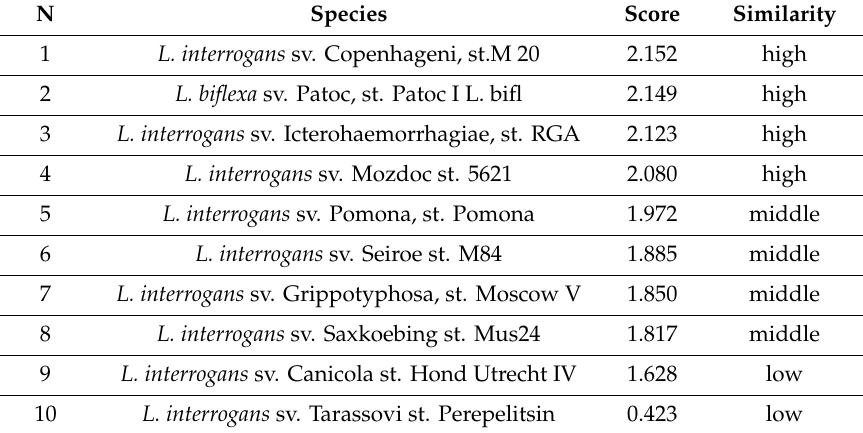
Table 1. The spectral coincidence of the studied Leptospira strain with the spectral profiles of 10 reference strains of Leptospira spp. represented in the project database MALDI Biotyper 3.1. N Species Score